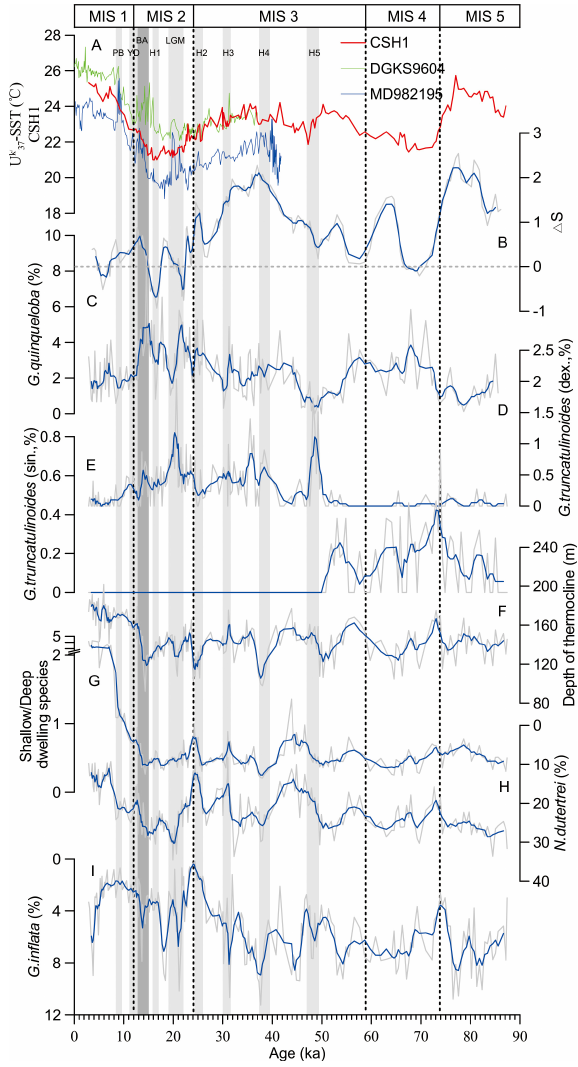
Figure 7. Time series plots of temperature, salinity, depth of the thermocline (DOT) and the ratio of shallow/deep species in core CSH1 as well as comparison with the abundances of G.quinqueloba , G.truncatulinoides , N.dutertrei and G.inflata in core CSH1 and other records in cores MD982195 (Ijiri et al., 2005) and DGKS9604 (Yu et al., 2009). Salinity values are given as the difference from the present-day climate, 1 S. Both the distributions of N. dutertrei and G.inflata are related to DOT, but they show dif- ferent down-core profiles in core CSH1. Gray bars are the same as those in Fig.